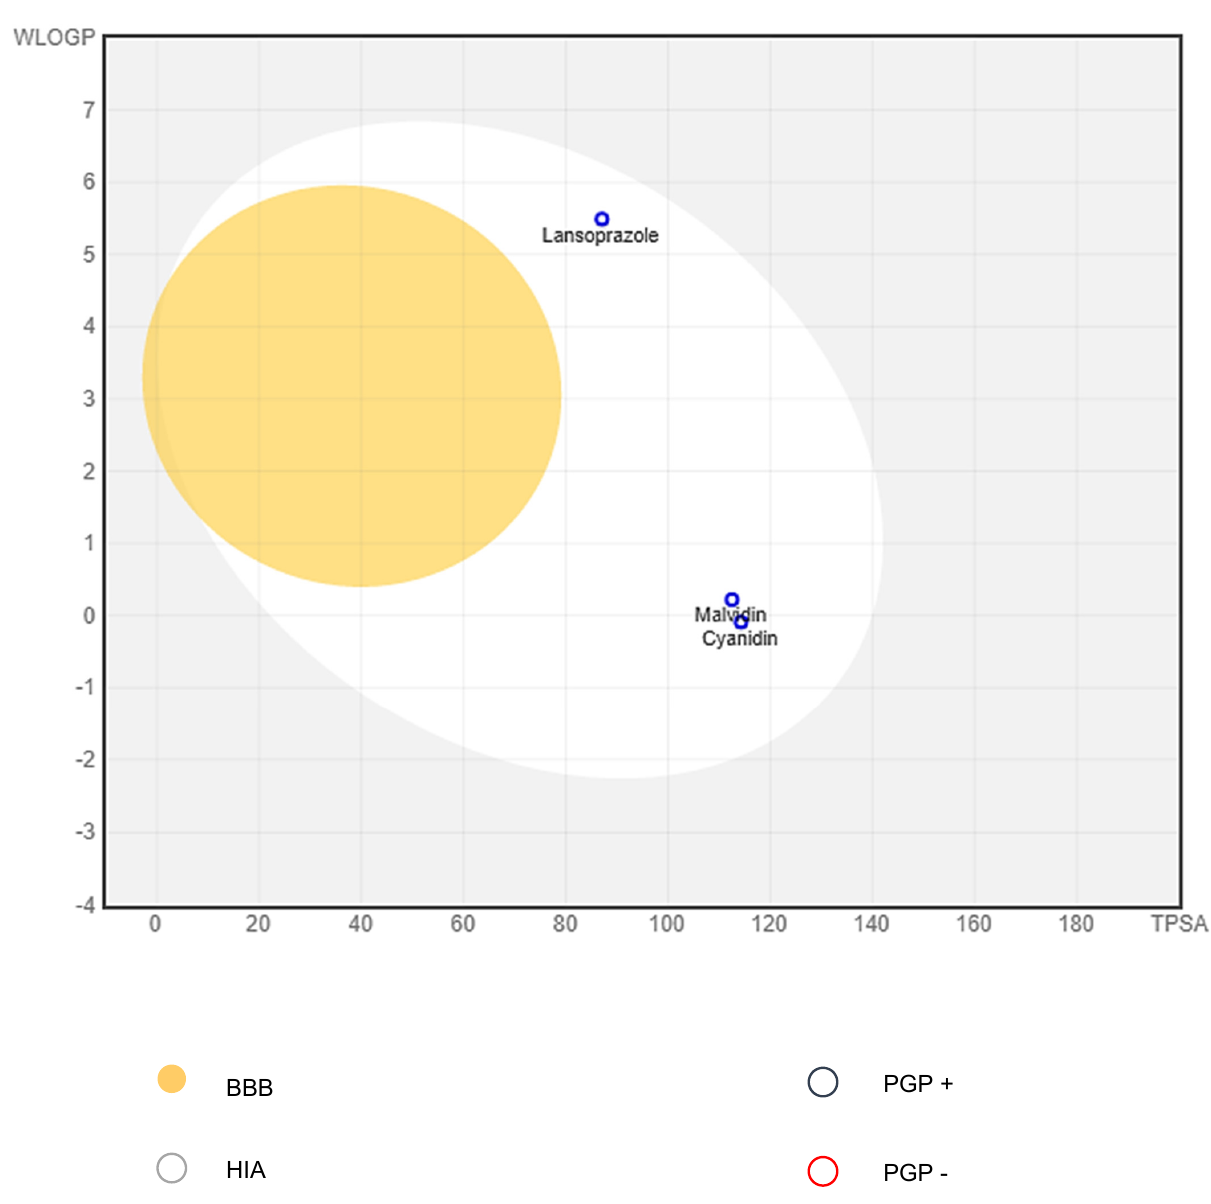
Figure 9. Comparative graphical representation (BOILED-Egg) for the molecules: lansoprazole, malvidin chloride and cyanidin chloride.